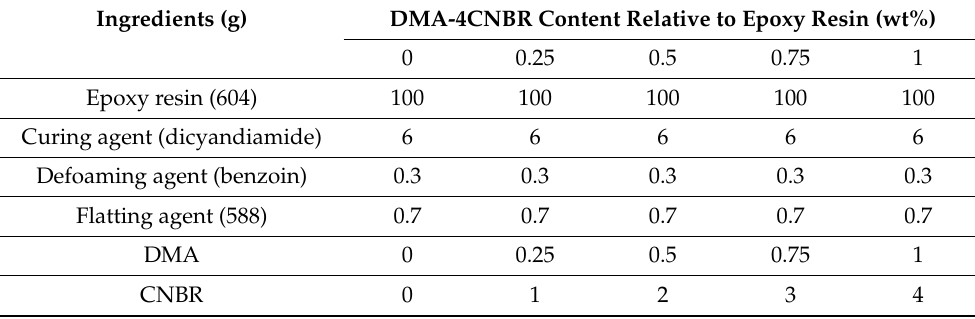
Table 1. Different formulations of the epoxy powder composite coatings. Ingredients